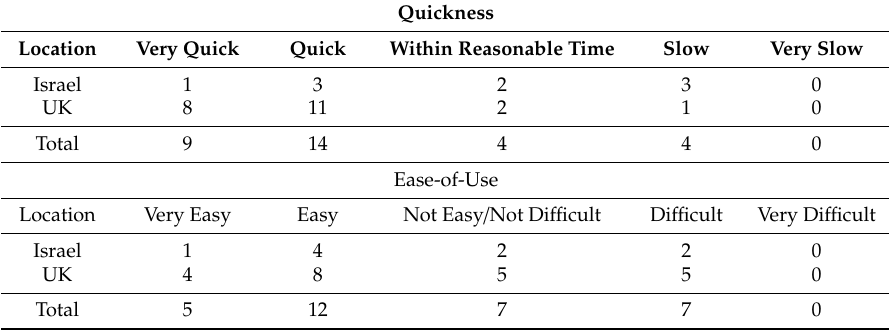
Table 5. The feasibility (quickness and ease-of-use) of the Equine Acute Abdominal Pain Scale (EAAPS) reported as the response of the first-time user by location (Israel; n = 9, UK; n = 22; UK missing; n =